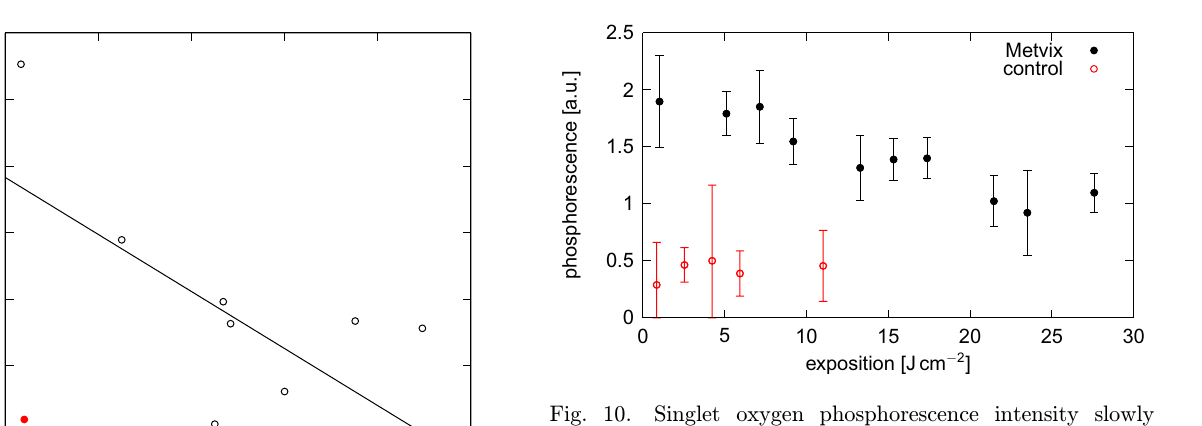
Fig. 10. Singlet oxygen phosphorescence intensity slowly drops with exposition of the lesion in Metvix treated animals (solid) while it remains unchanged in the control (open) ones during the treatment.